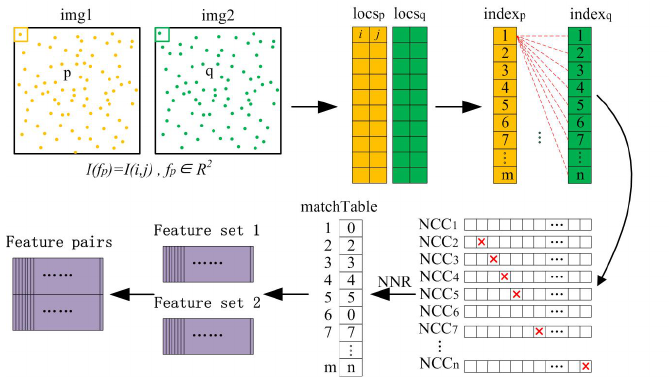
Figure 7. The basic flowchart of data